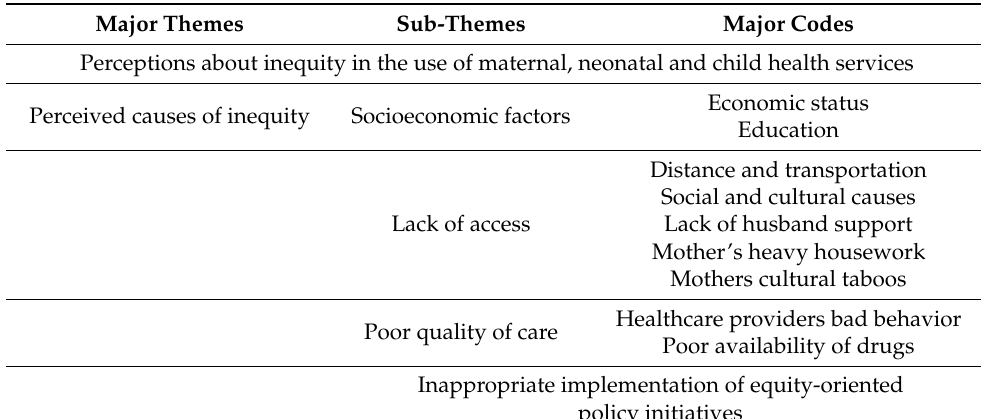
Table 1. List of major themes and sub-themes that emerged during the analysis.